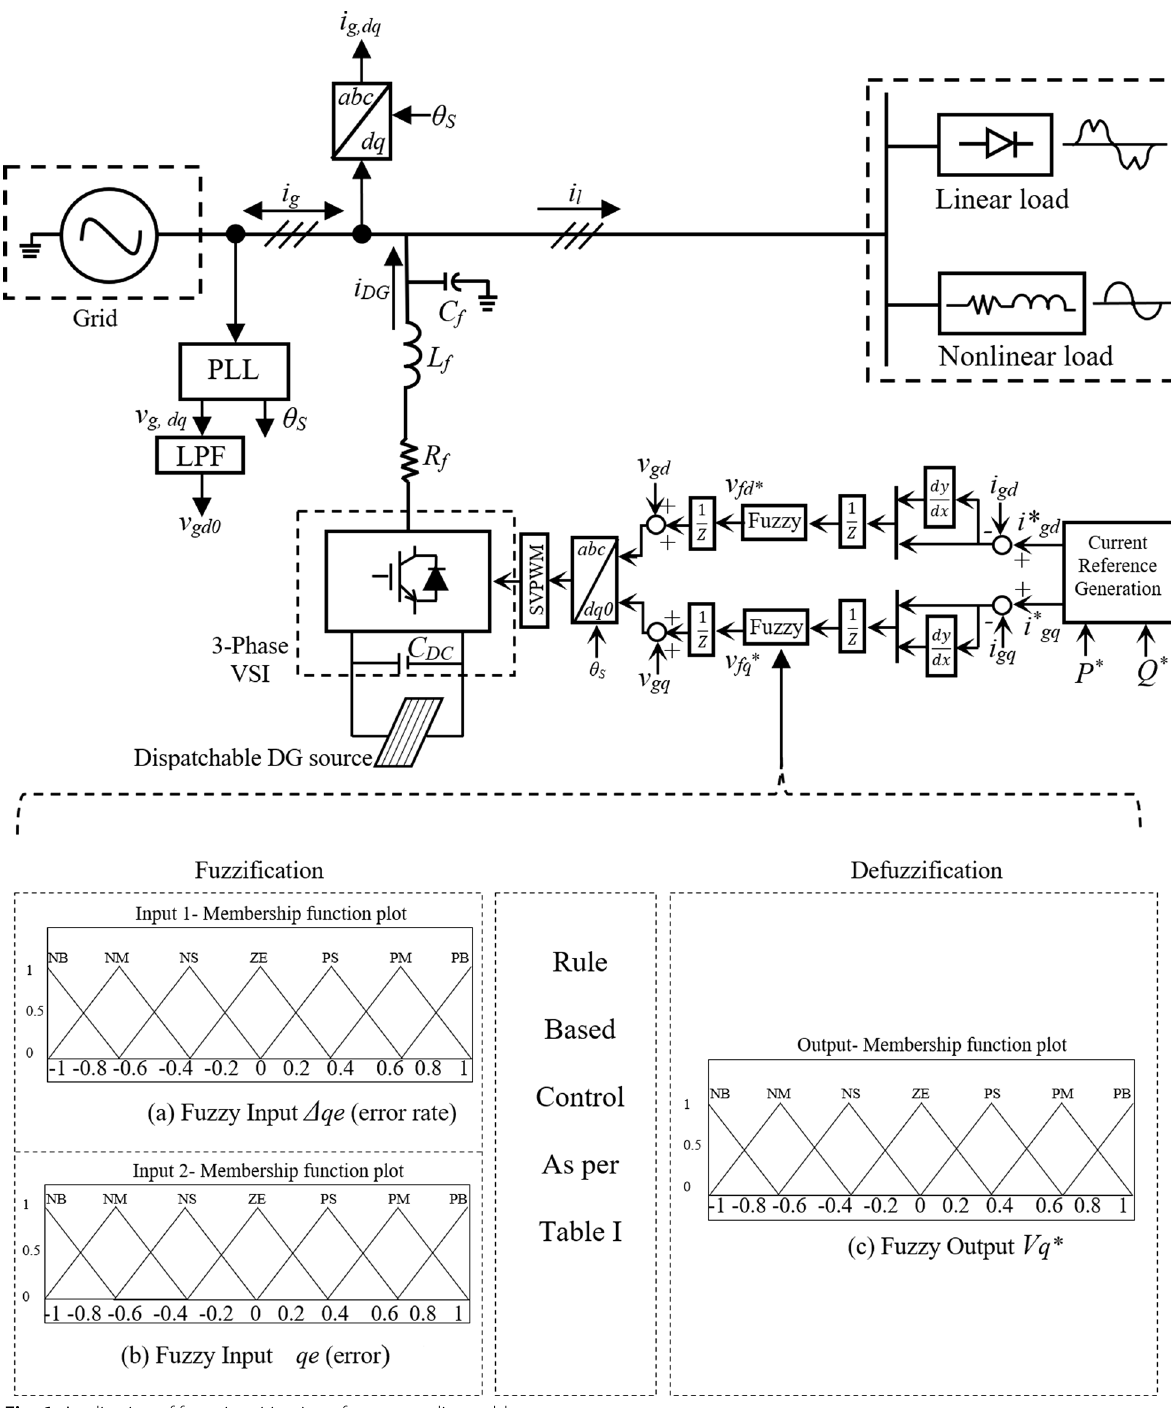
Fig. 6 Application of fuzzy in mitigation of power quality